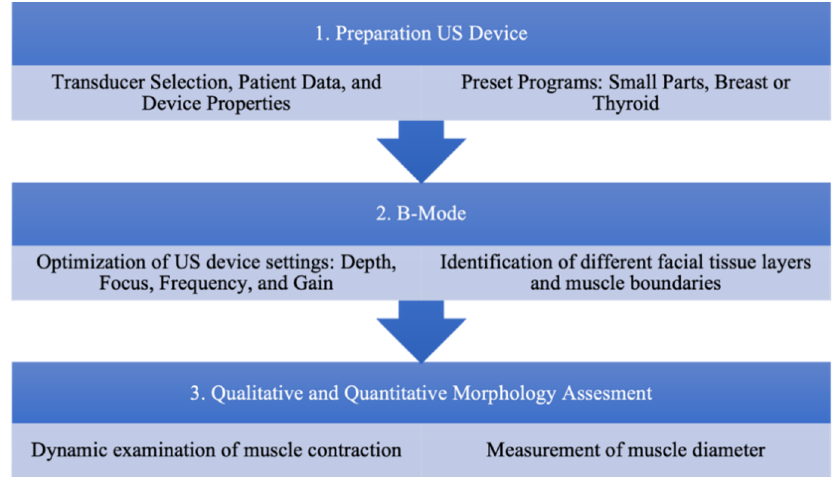
Figure 3. Standardized ultrasound (US) protocol for an effective facial muscle examination. First, the US device is to be prepared for the following examination by selecting an appropriate transducer and preset program. Next step, the brightness (B)-mode can be used to determine different facial tissue layers. Finally, the qualitative and quantitative assessments of muscular morphological features is performed by measuring the cross-sectional muscular diameter and evaluating the muscle functionality in motion.